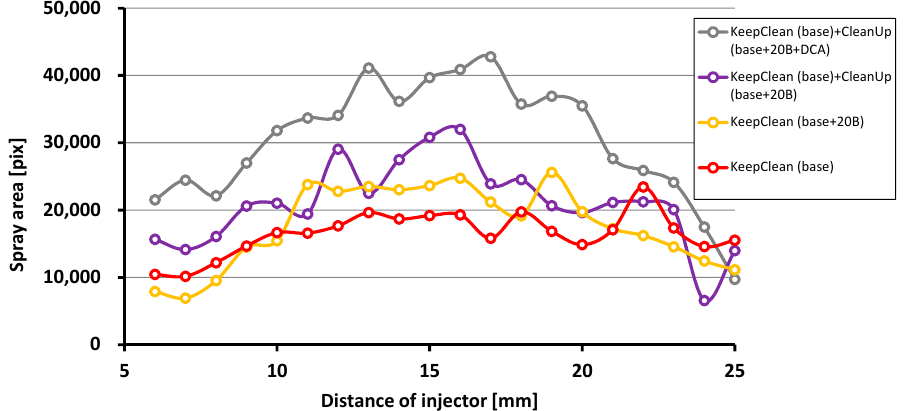
Figure 11. The course of changes in the areas of the fuel spray (the sum of the six streams from the beginning of the analysis—6 mm to the end—25 mm) in cross ‐ sections.